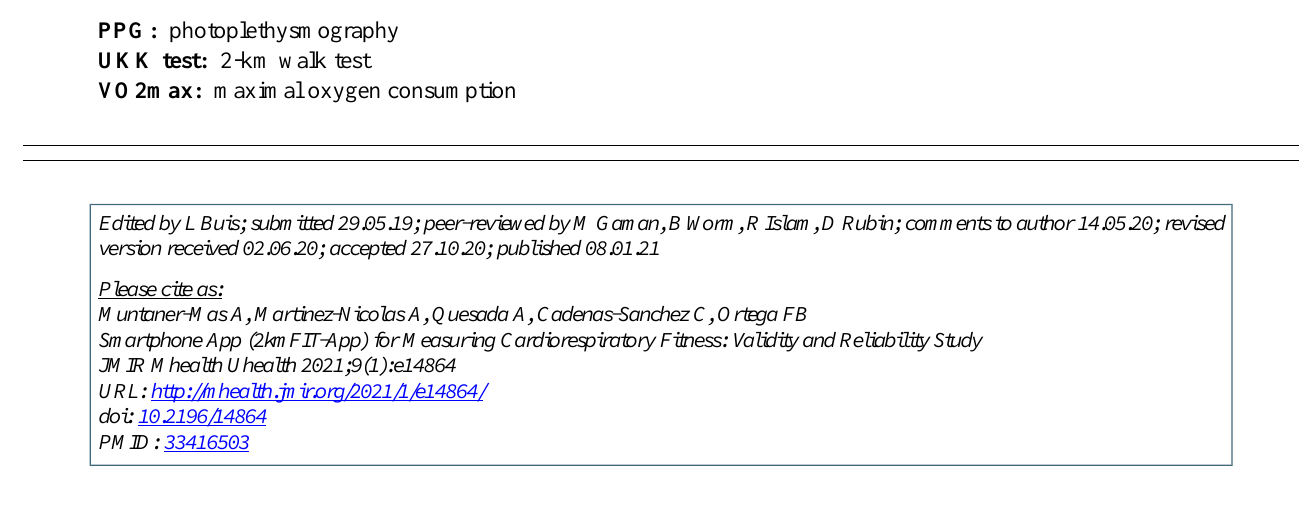
PPG: photoplethysmography UKK test: 2-km walk